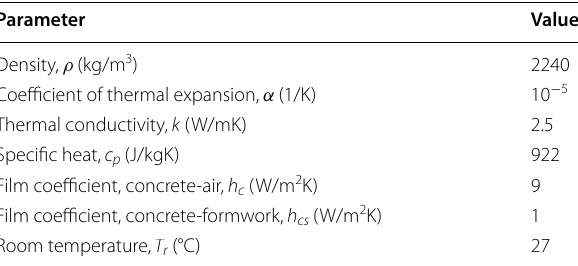
Table 2 Thermophysical parameters considered in the thermal analysis.